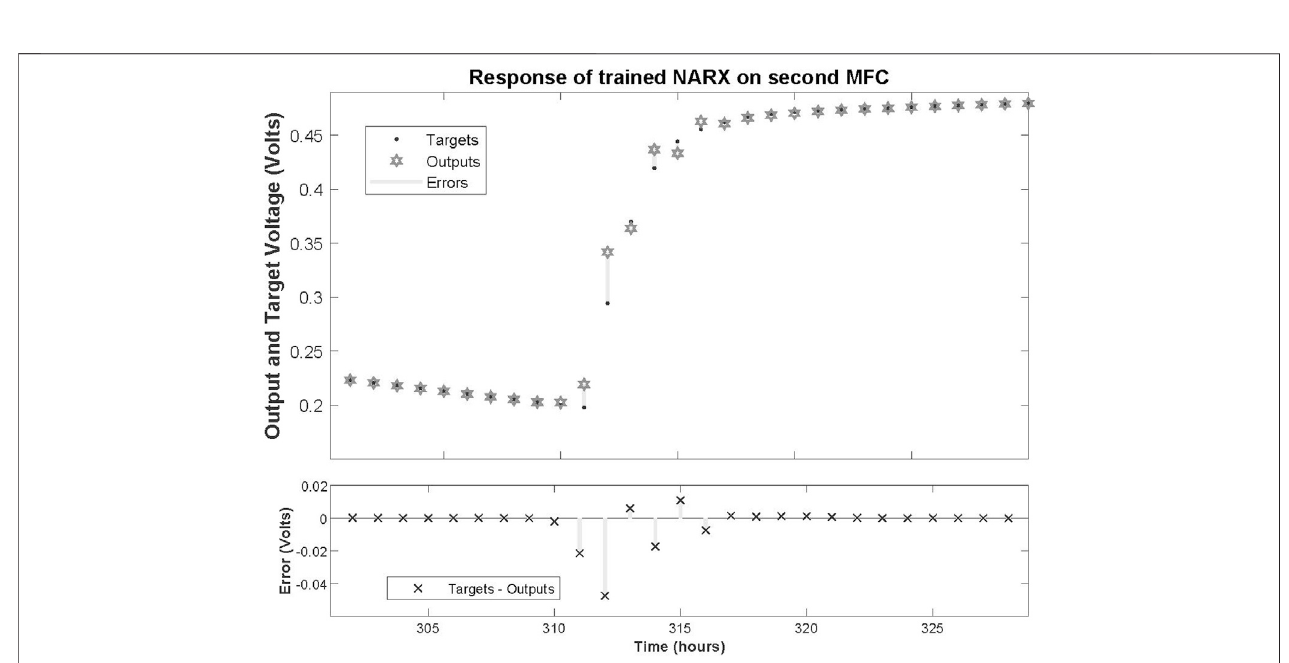
FIGURE 8 | Zoomed in response of trained NARX on dataset time-series of second MFC at the second re fi lling of feedstock and associated errors.